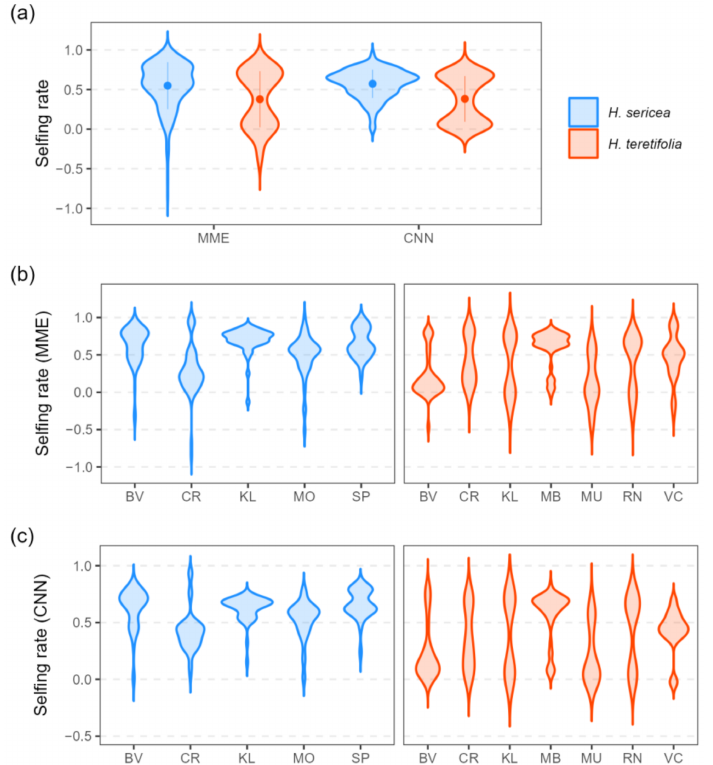
Figure 3. Violin plots (Gaussian kernel density estimates) of individual progeny selfing rates inferred using MME and CNN approaches for H. sericea (blue) and H. teretifolia (orange); per species ( a ), and per site ( b , c